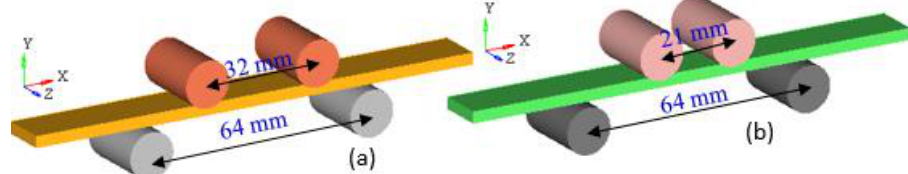
Figure 2. Finite element models for four-point bending cases. ( a ) Short beams, ( b ) long beams.